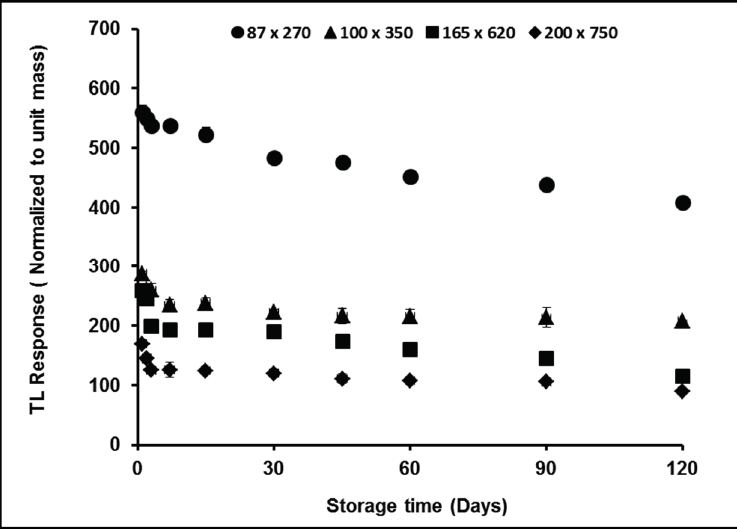
Figure 7. The loss of TL yield over a period of 120 days post-irradiation for the variously dimensioned Ge-doped flat fibers, irradiated to a dose of 2 Gy using the 60 Co gamma source. (Note: In some cases the error bars are smaller than the size of individual data